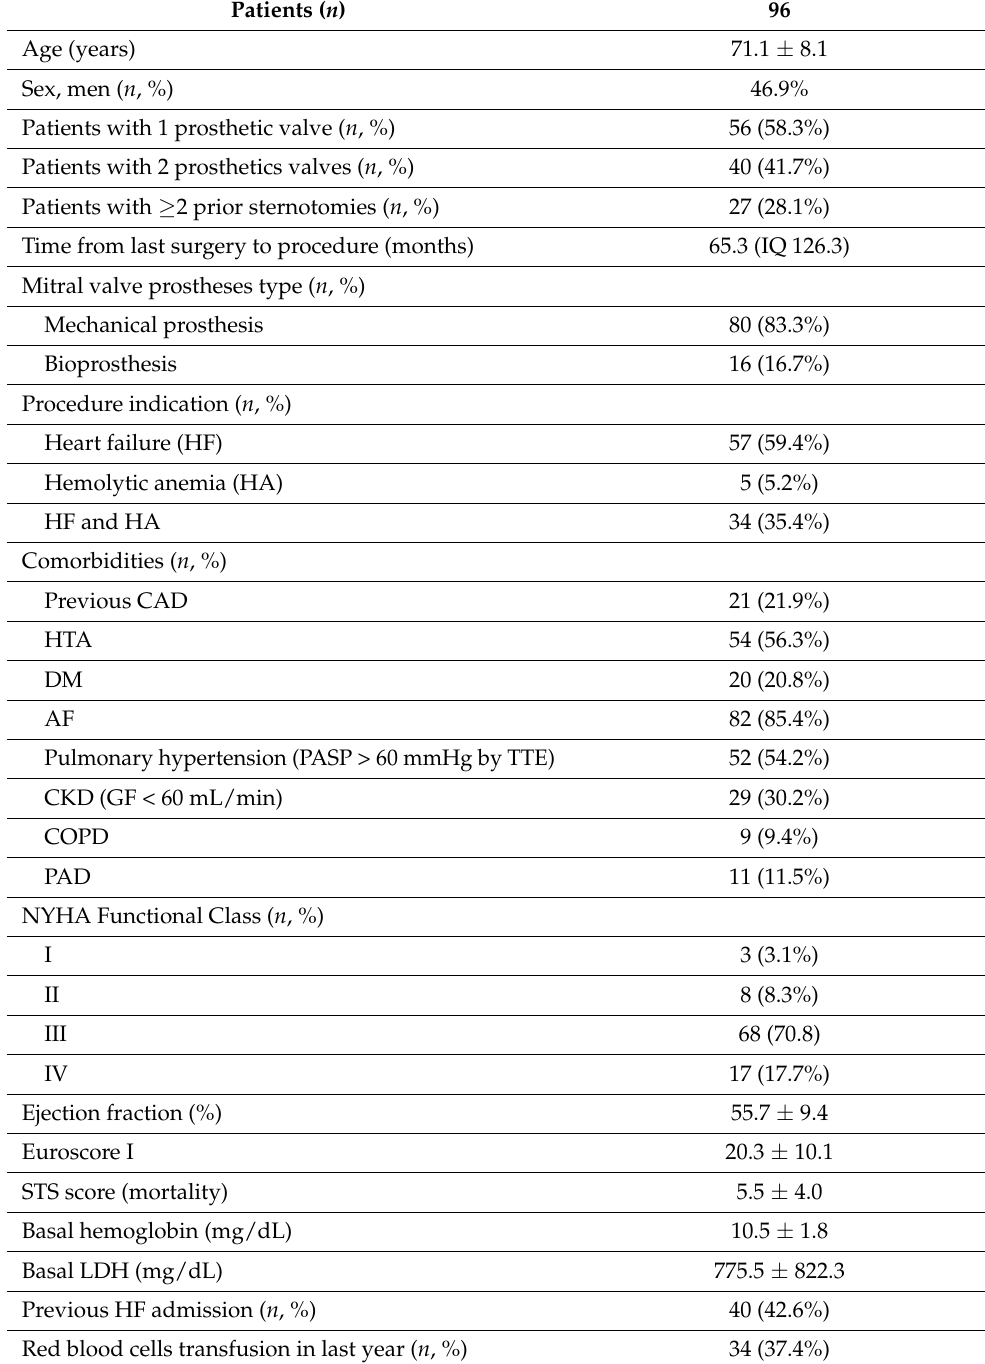
Table 1. Baseline